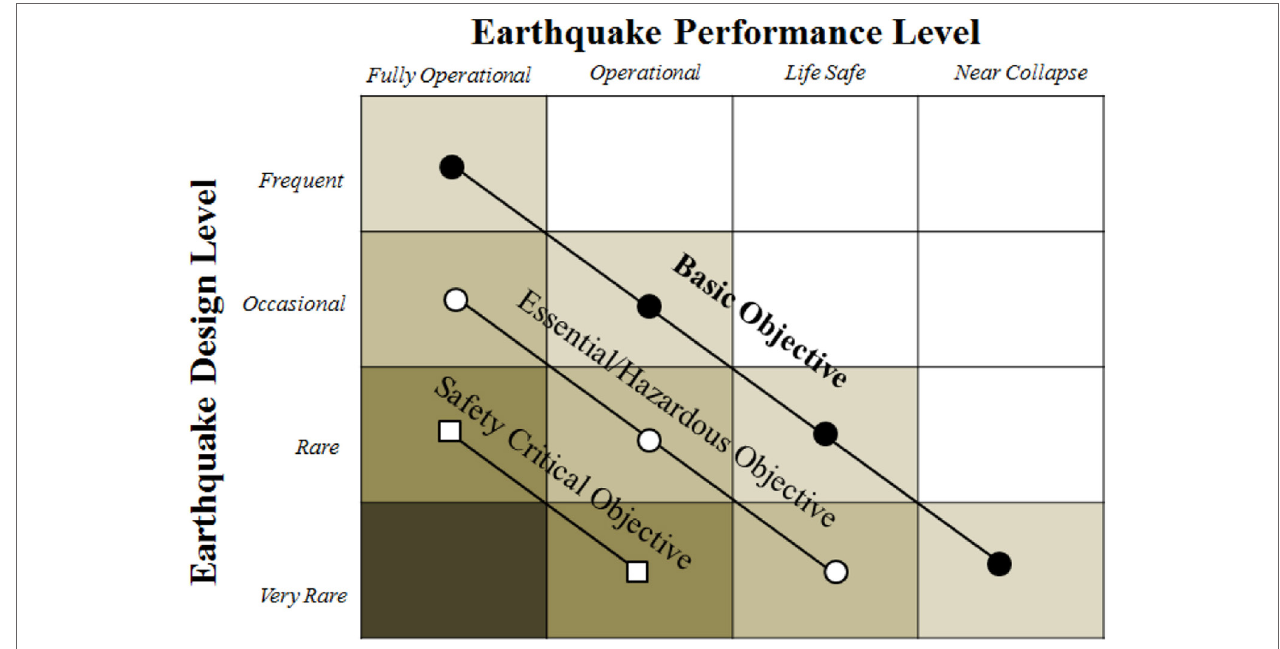
FigURe 3 | Performance Objectives for buildings [adapted from SEAOC Vision 2000 Committee